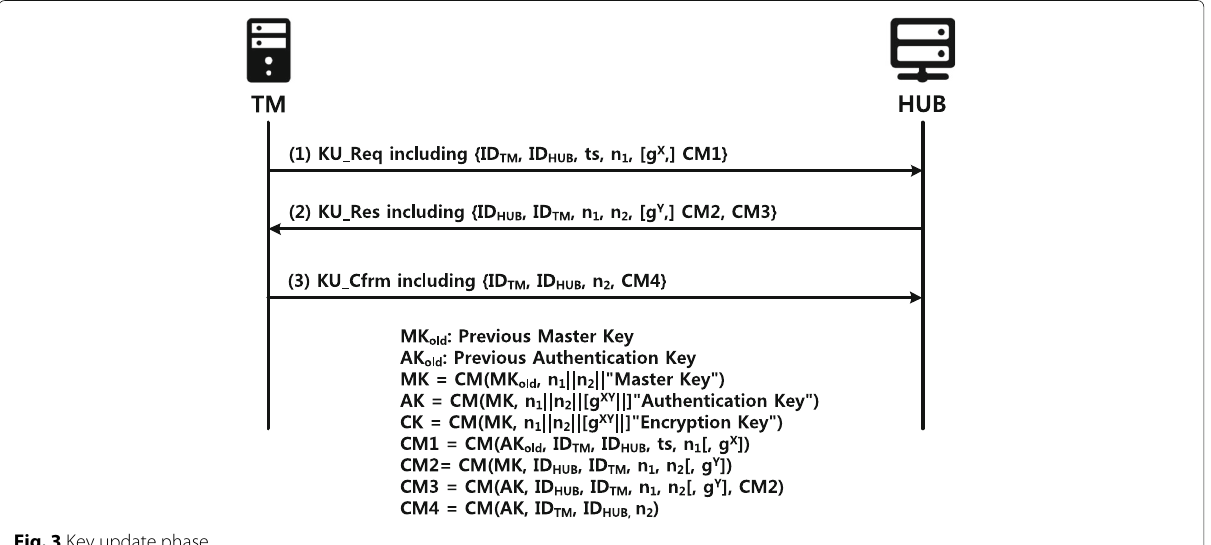
Fig. 3 Key update